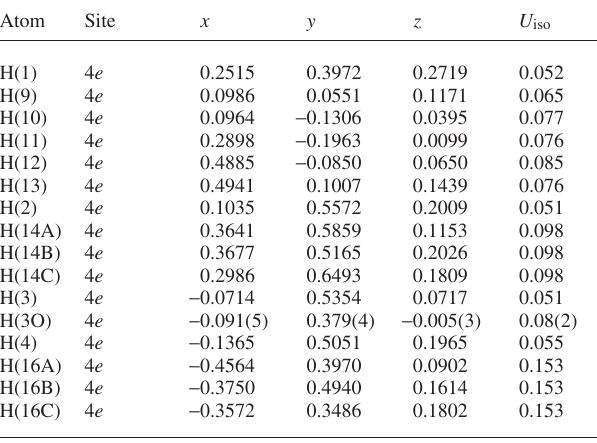
Table 2. Atomic coordinates and displacement parameters (in Å 2 )